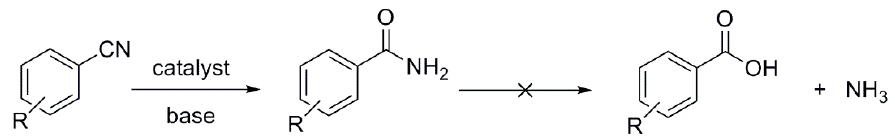
Table 4. Effect of various bases on the hydration of benzonitrile catalyzed by [RhCl(cod)(IMes)] ( 1 ). Entry Base Conversion (%) TOF a (h − 1 )